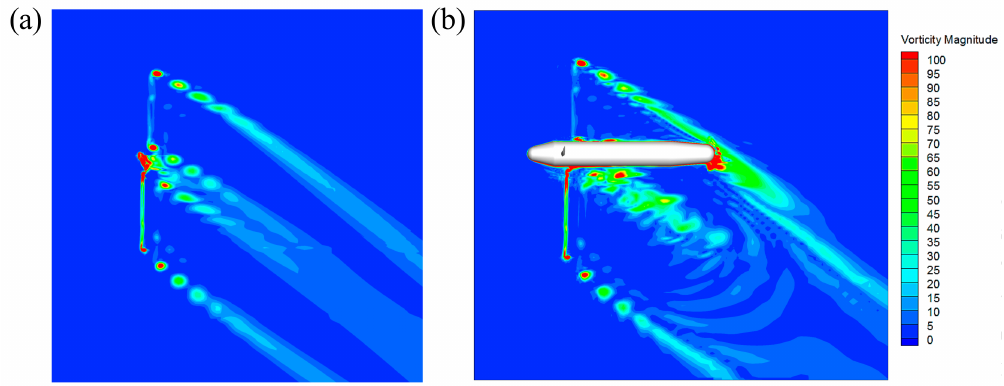
Figure 8. Contours of vorticity magnitude on the horizontal plane when blade pointing to + z direction: ( a ) nacelle is not included; ( b ) nacelle is